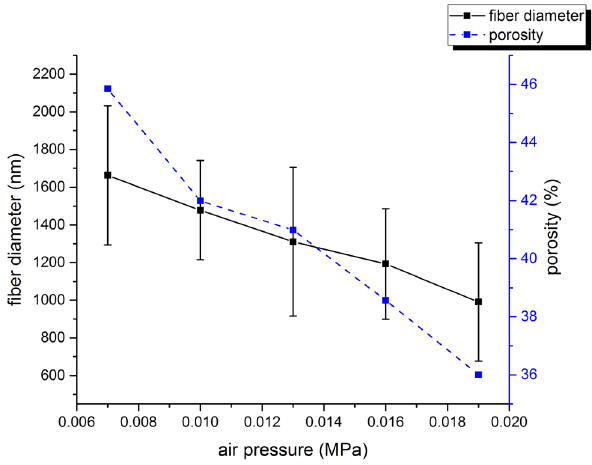
Figure 4: The relationships between CSBS fi ber diameter, CSBS nonwoven porosity, and air